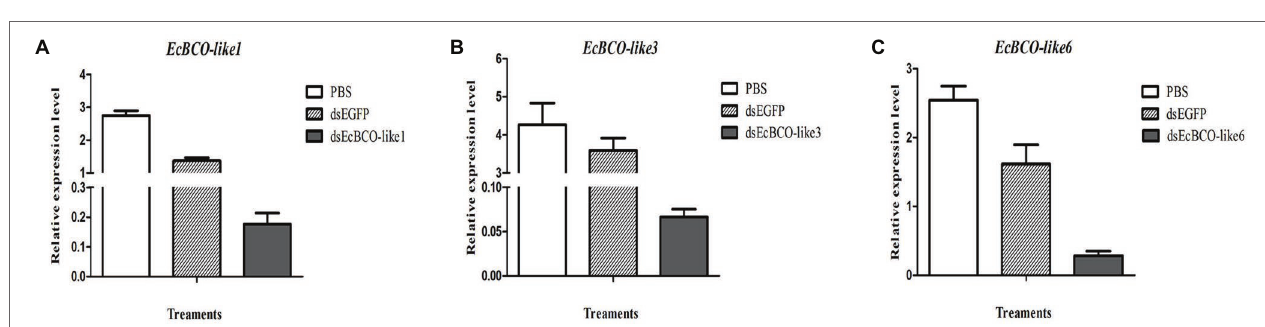
FIGURE 3 | Tissue distribution of EcBCO-like1 (A) ; EcBCO-like2 (B) ; EcBCO-like3 (C) ; EcBCO-like4 (D) ; EcBCO-like5 (E) ; EcBCO-like6 (F) ; EcBCO-like7 (G) ; carotenoid isomerooxygenase like1 (H) and carotenoid isomerooxygenase like2 (I) . Hc, hemocytes; Epi, epidermis; In, intestine; Gi, gill; Hp, hepatopancreas; Ms., muscle; St, Stomach; Ht, heart; Tg, thoracic ganglia; Vn, ventral nerve cord; and Es,